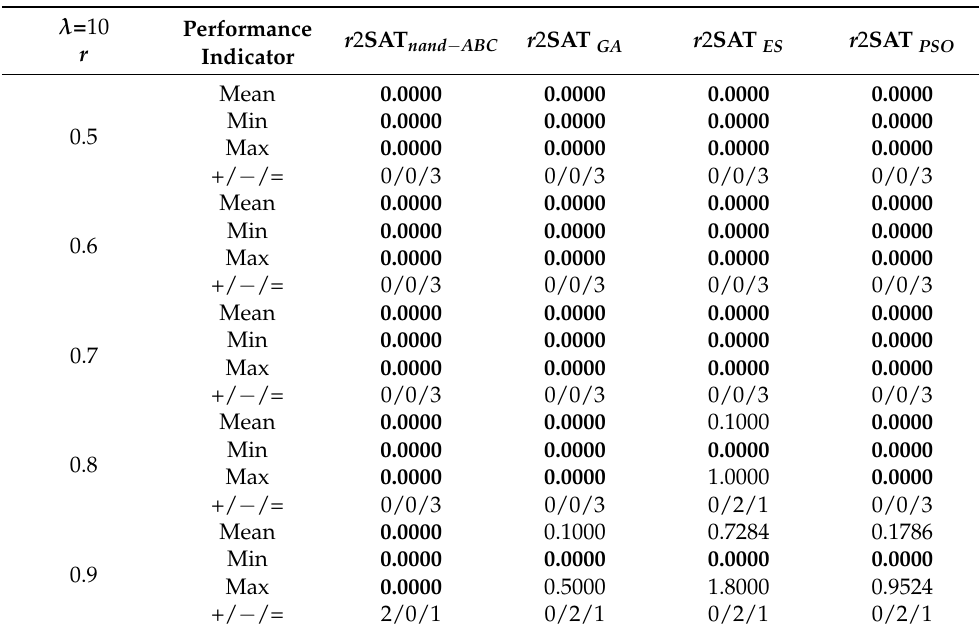
Table 16. Comparison of r 2SAT nand − ABC against other binary algorithms in terms of MAE for λ = 10.